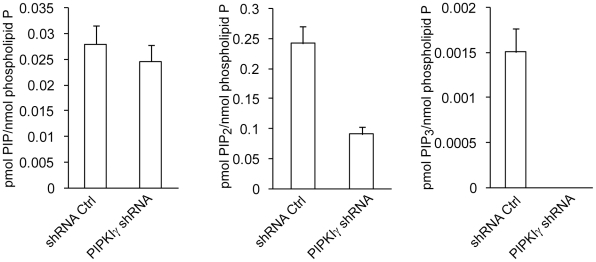
PIPKIγ is a major enzyme responsible for PIP2 and PIP3 production in HCT116 cells.Polyphosphoinositides from cells stably expressing shRNA control or PIPKIγ shRNA were extracted and derivatized using trimethylsilyl diazomethane, and then were measured using mass spectrometry. N = 4, error bar = mean ± s.e.m; PIP, P>0.05; PIP2, P = 0.0034; PIP3, P = 0.001.